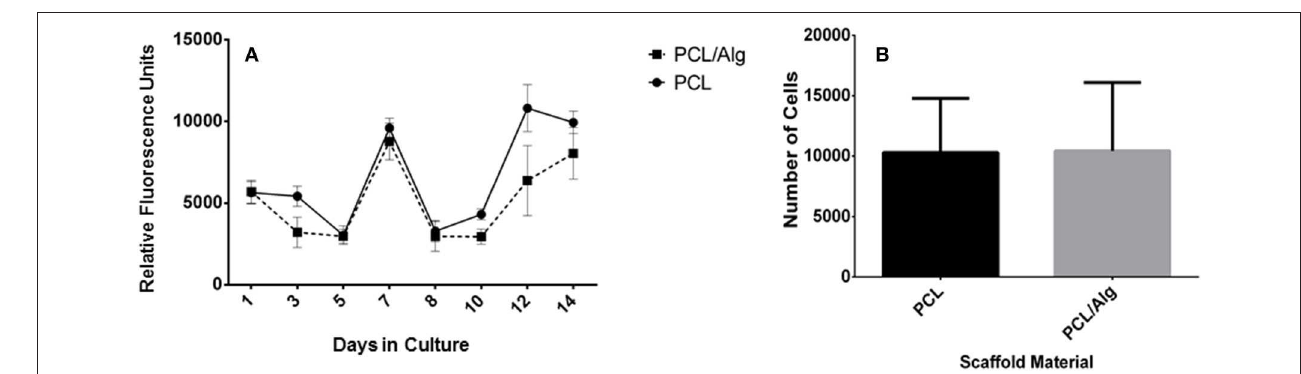
Frontiers in Bioengineering and Biotechnology |